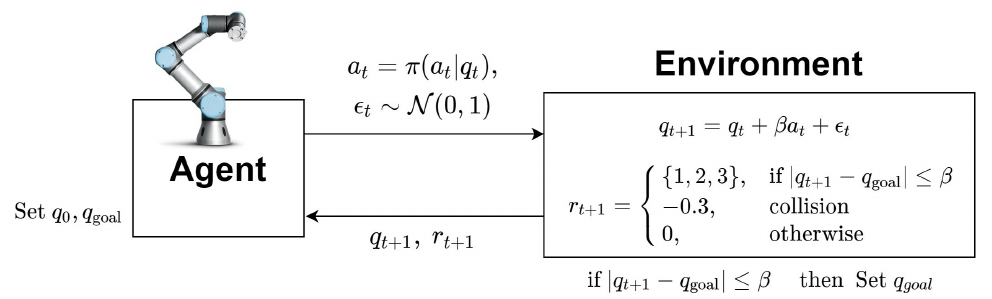
Figure 10. Schematic of MDP in robot manipulation